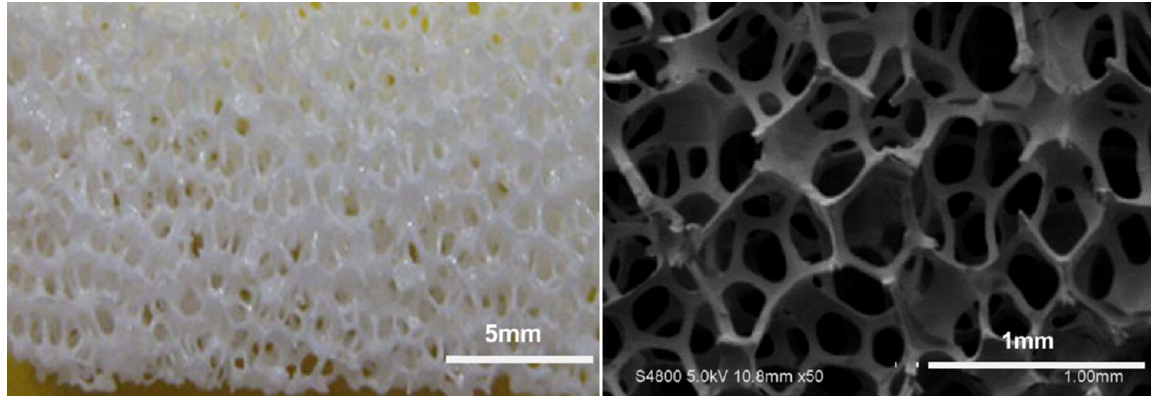
Figure 3: The image of sintered nano-porous zro 2 scaffolds and SEM image of a sintered zro 2 scaffold with interconnectivity